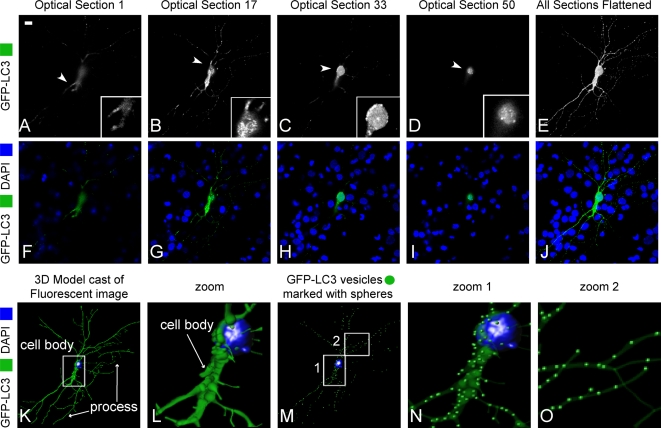
Confocal imaging and three-dimensional model reconstruction of neuron transfected with GFP-LC3.(A–J) Confocal images of different z sections (0.2 µm of thickness) of a neuron transfected with GFP-LC3 (A–D) and all sections are flattened (E). Higher magnification images of the area outlined in white are shown in the inserts (A–D). Different sections of images of transfected neuron with GFP-LC3 (green) merged with DAPI (blue). Scale bar, 20 µm. (K–O) Three-dimensional reconstruction from serial sections using IMARIS software, cell body and process (K) and higher magnification of the zoomed area outlined in white (K-I). Reconstructed 3D image of the same neuron using IMARIS, which evaluates AV localization in the reconstructed 3D image (M–O). Enlarged areas of neuron revealed the presence of AV in soma and neurites (N–O).